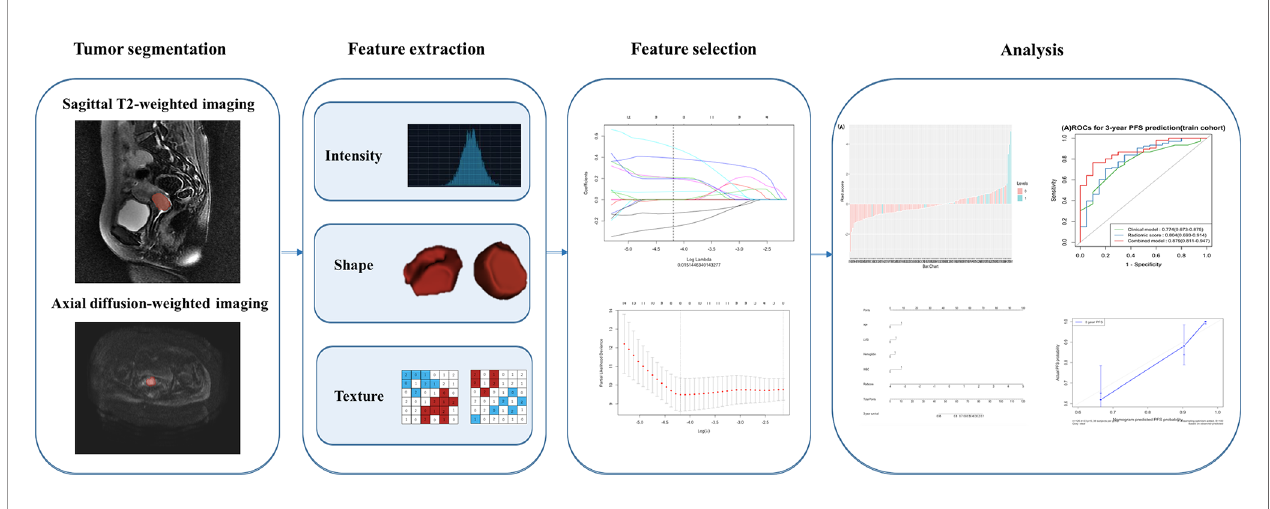
FIGURE 1 | The radiomics work fl